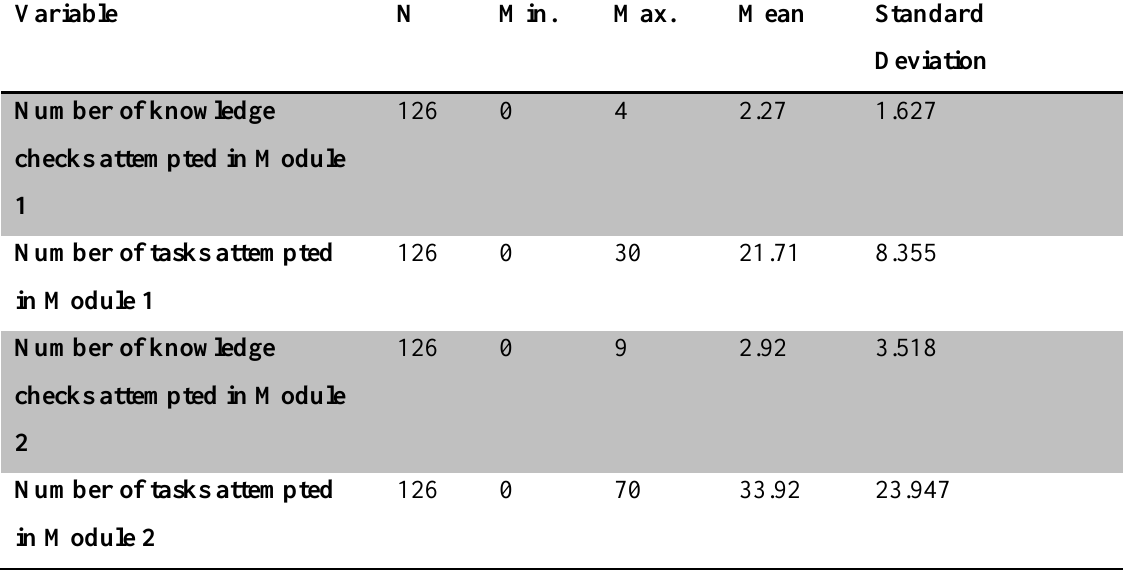
Table 1: Average numbers of knowledge checks and tasks attempted in Modules 1 and 2 A series of histograms (Figures 1, 2, 3 and 4) shows the distribution of quiz and task completions across both